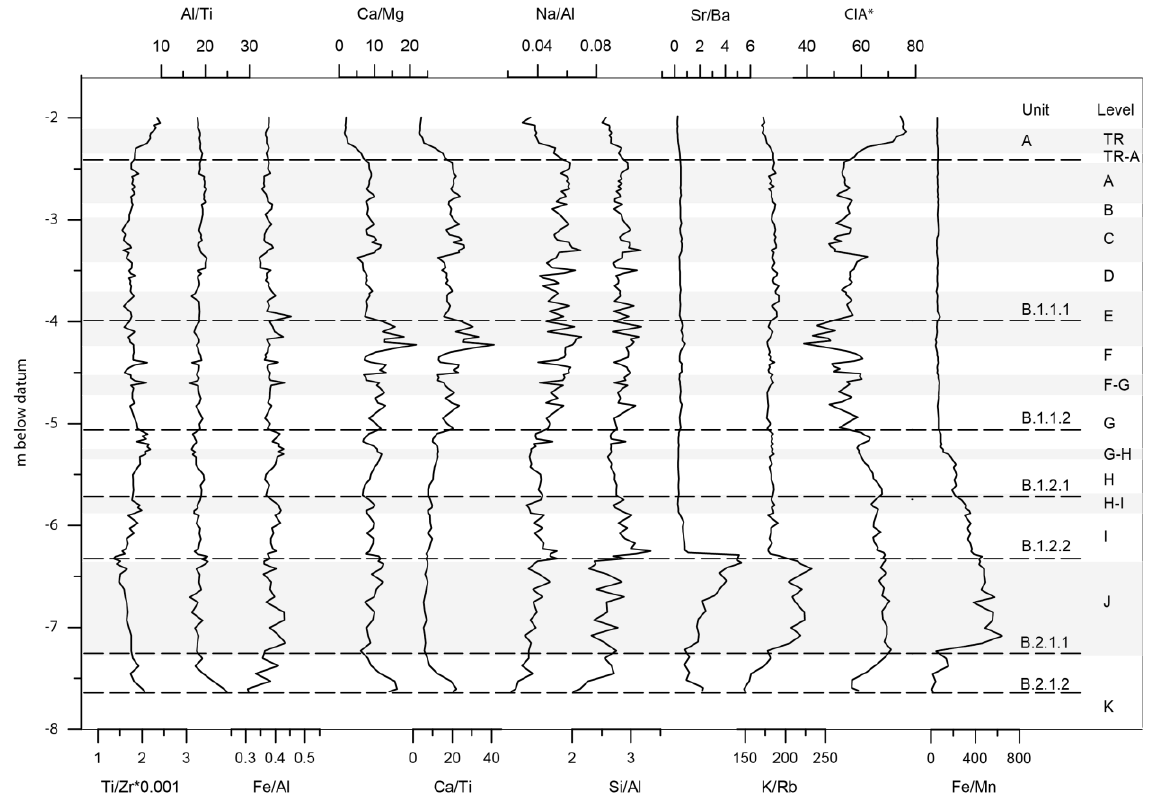
Figure 8. Geochemical ratios for the fine fraction ( < 2mm in diameter) of the north profile at square E 0 at Figure 8: Geochemical ratios for the fine fraction (< 2 mm in diameter) of the north profile at 2 square E0 at Arbreda.. 3